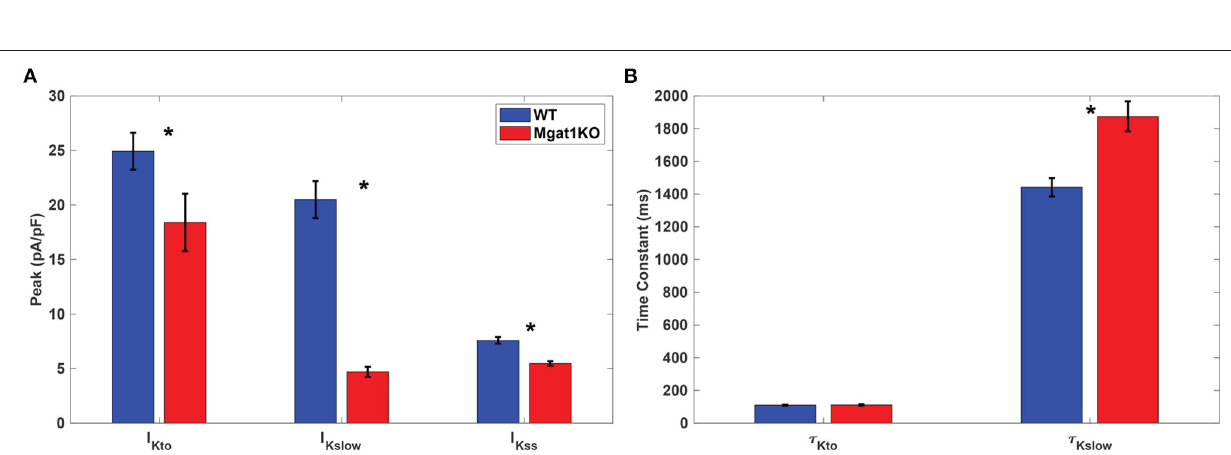
Frontiers in Physiology |